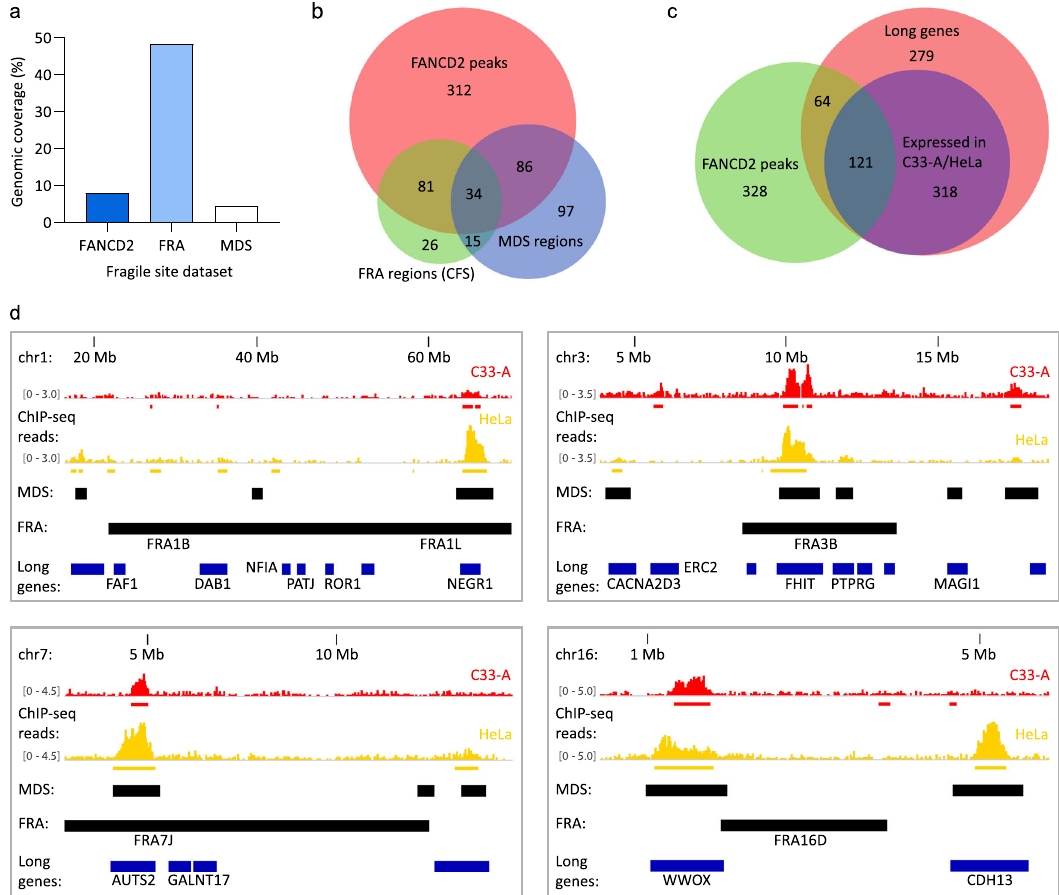
Fig. 5 Cervical keratinocyte-speci fi c fragile sites mapped by FANCD2 ChIP-seq. HPV-negative (C33-A) and HPV18-positive (HeLa) cervical carcinoma cells were treated for 24 h with 0.2 µM aphidicolin and FANCD2-enriched regions were identi fi ed by ChIP-seq. All analyses were performed using the combined C33-A and HeLa FANCD2 dataset. a Bar graph showing the genomic coverage of FANCD2-enriched regions relative to common fragile sites (FRA regions) and mitotic DNA synthesis (MDS) regions reported in the literature 19,20 . b Venn diagram showing the regions of overlap between fragile sites identi fi ed in the FANCD2, FRA, and MDS datasets. c Venn diagram showing the overlap of FANCD2-associated fragile sites with protein-coding genes longer or equal to 0.3 Mb. Red circle represents all long genes; blue circle represents long genes that are expressed in C33-A and/or HeLa cells. d Alignment of FANCD2-enriched regions in C33-A (red) and HeLa (yellow) cells with associated genes (blue bars represent genes >0.3 Mb; genes expressed in C33-A and/or HeLa cells are indicated by gene name), and FRA and MDS regions (black bars). Red and yellow bars below the FANCD2 ChIP-seq signal tracks represent peaks mapped by SICER analysis in the corresponding cell lines. Relative ChIP-seq peak heights are indicated in square